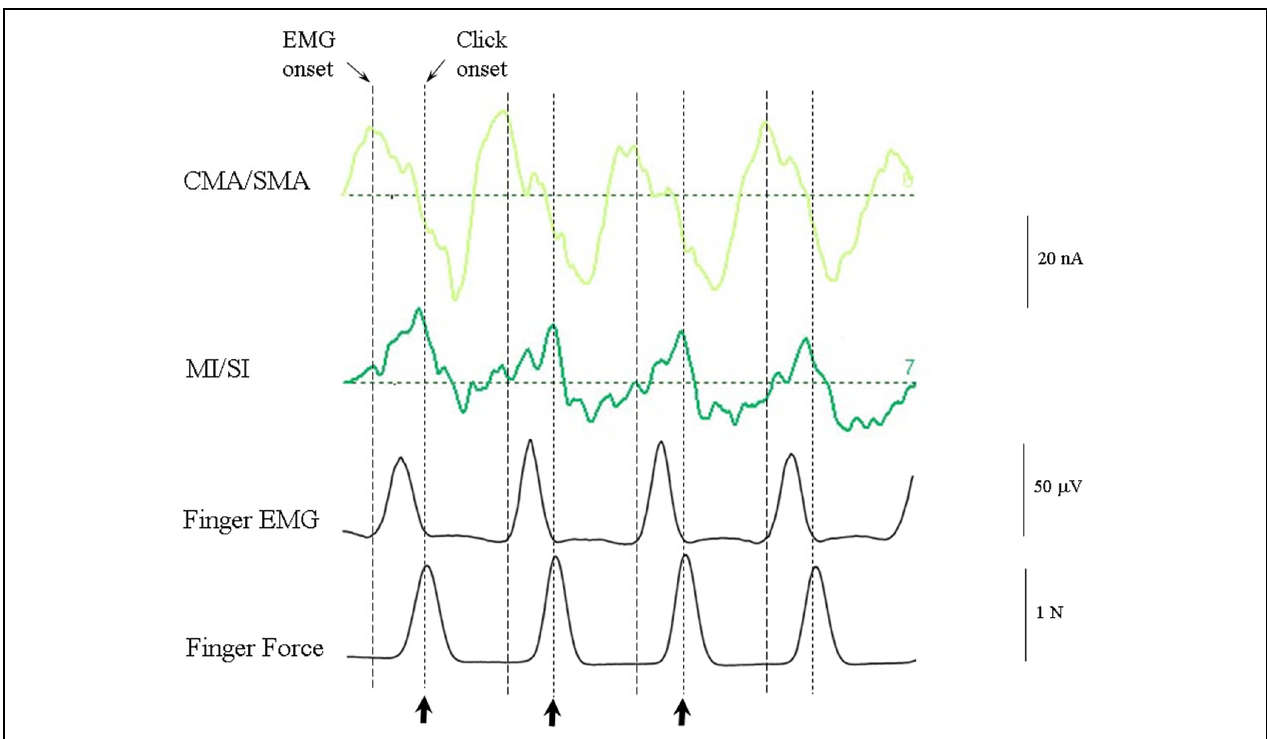
FIGURE 9 | CMA/SMA and MI/SI sources aligned with the finger EMG and finger force activity. The CMA/SMA activity is at maximum negative (corresponding to the peak pre-movement negative wave, or PMN) at the onset